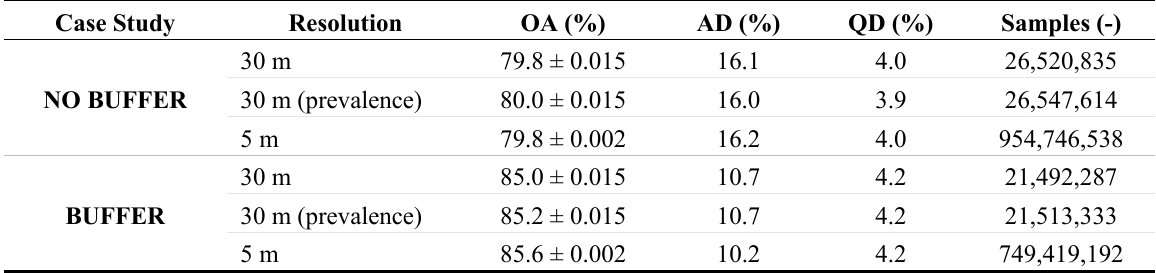
Table 10. Comparison between GlobeLand30 2010 and DUSAF4.0 (II classification): overall statistics and number of samples for the two cases of no buffer and buffer and for different resolutions. OA: overall accuracy (confidence intervals at 95% probability); AD: allocation disagreement; QD: quantity